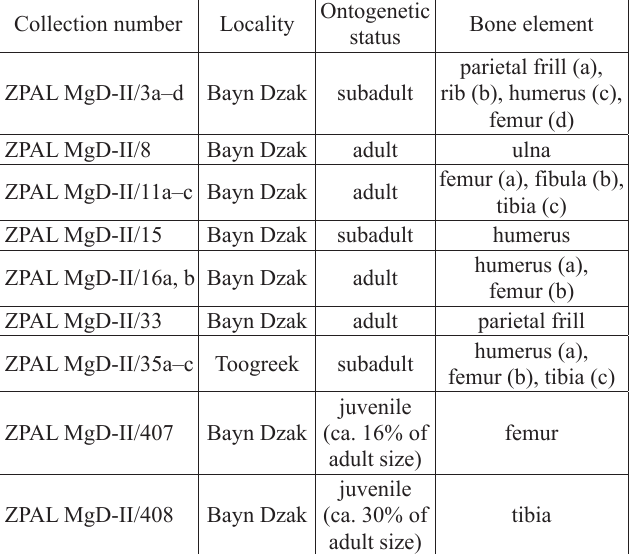
Table 1. Protoceratops material used in this study.